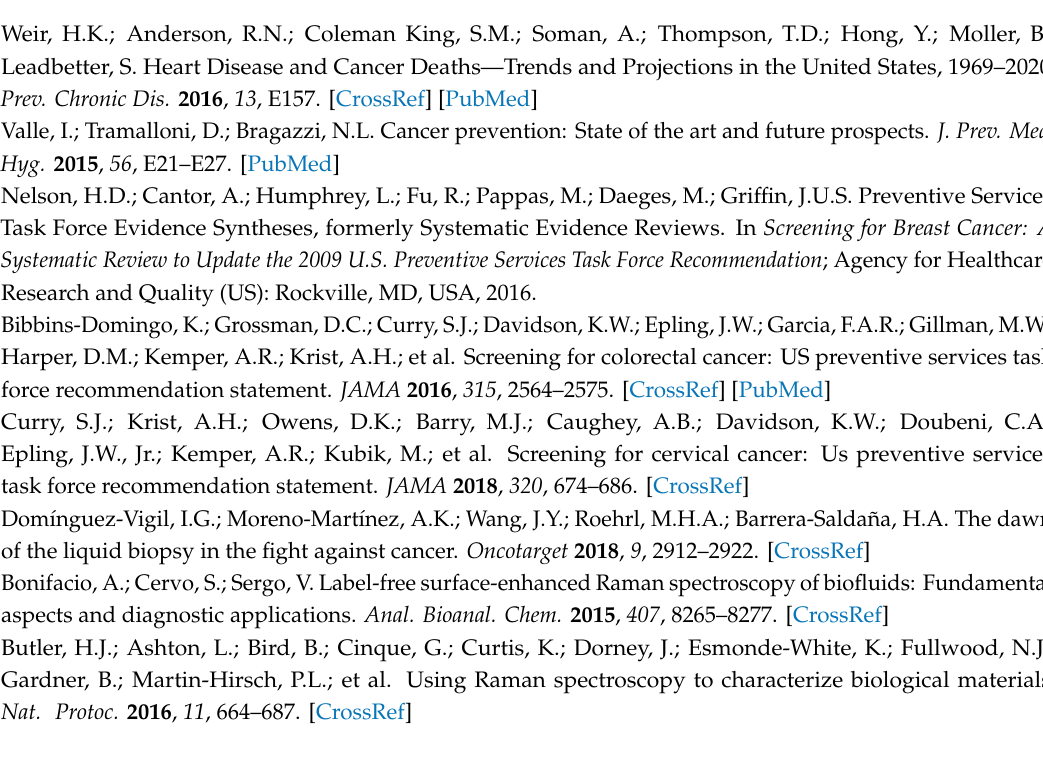
Figure S1: The UV-Vis absorbance spectrum of hya-AgNPs. Figure S2: The loading plots corresponding to PCs 3–7, which resulted from the PCA analysis of the SERS spectra of serum samples of n = 53 patients with gastrointestinal tumors and of n = 25 Ctrl subjects (the loading plots of PC 1 and PC 2 are shown in Figure 3). Table S1: The demographic and clinical information of patients and controls. Table S2: The results of Levene’s test for the first seven PCs and the inflammatory markers. P -value < 0.05 shows significant di ff erence between the control and GCRC groups. Table S3: The results of the univariate data analysis for the CRP level, neutrophil count, platelet count and hemoglobin level. Table S4: The descriptive statistics for the first seven PCs and for the inflammatory markers for the two groups, Ctrl and